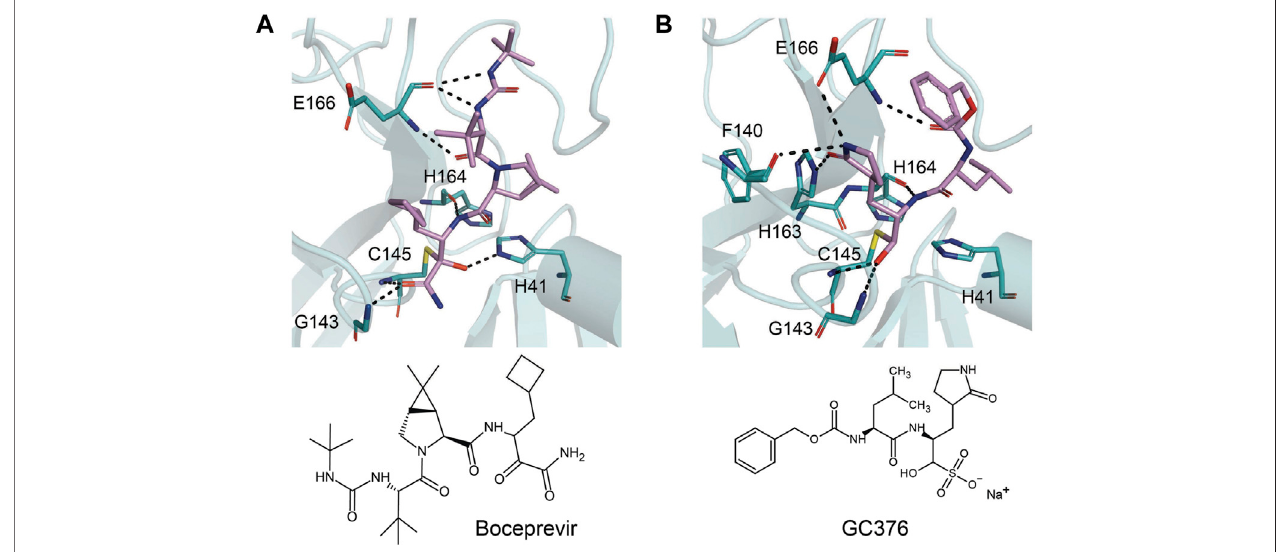
FIGURE11| Close-upviewoftheinteractionsbetweenSARS-CoV-2MprowithBoceprevirandGC376.Close-upviewofinteractionbetweenSARS-CoV-2Mpro and inhibitors in crystal structures. Mpro is shown as cartoon representation, with residues involved in the interaction shown as sticks. Inhibitors are shown as violet sticks. Hydrogen bonds were labeled with dashed lines. (A) Boceprevir (PDB: 7C6S). (B) GC376 (PDB: